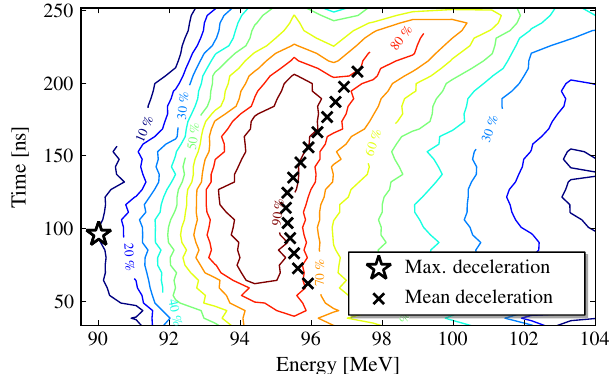
FIG. 7. The measured energy spectrum at the time instant with the most decelerated particles in Fig. 6. In addition, we show a simulated steady-state energy profile from PLACET for a form factor of F f λ ð z Þg ¼ 0 . 95